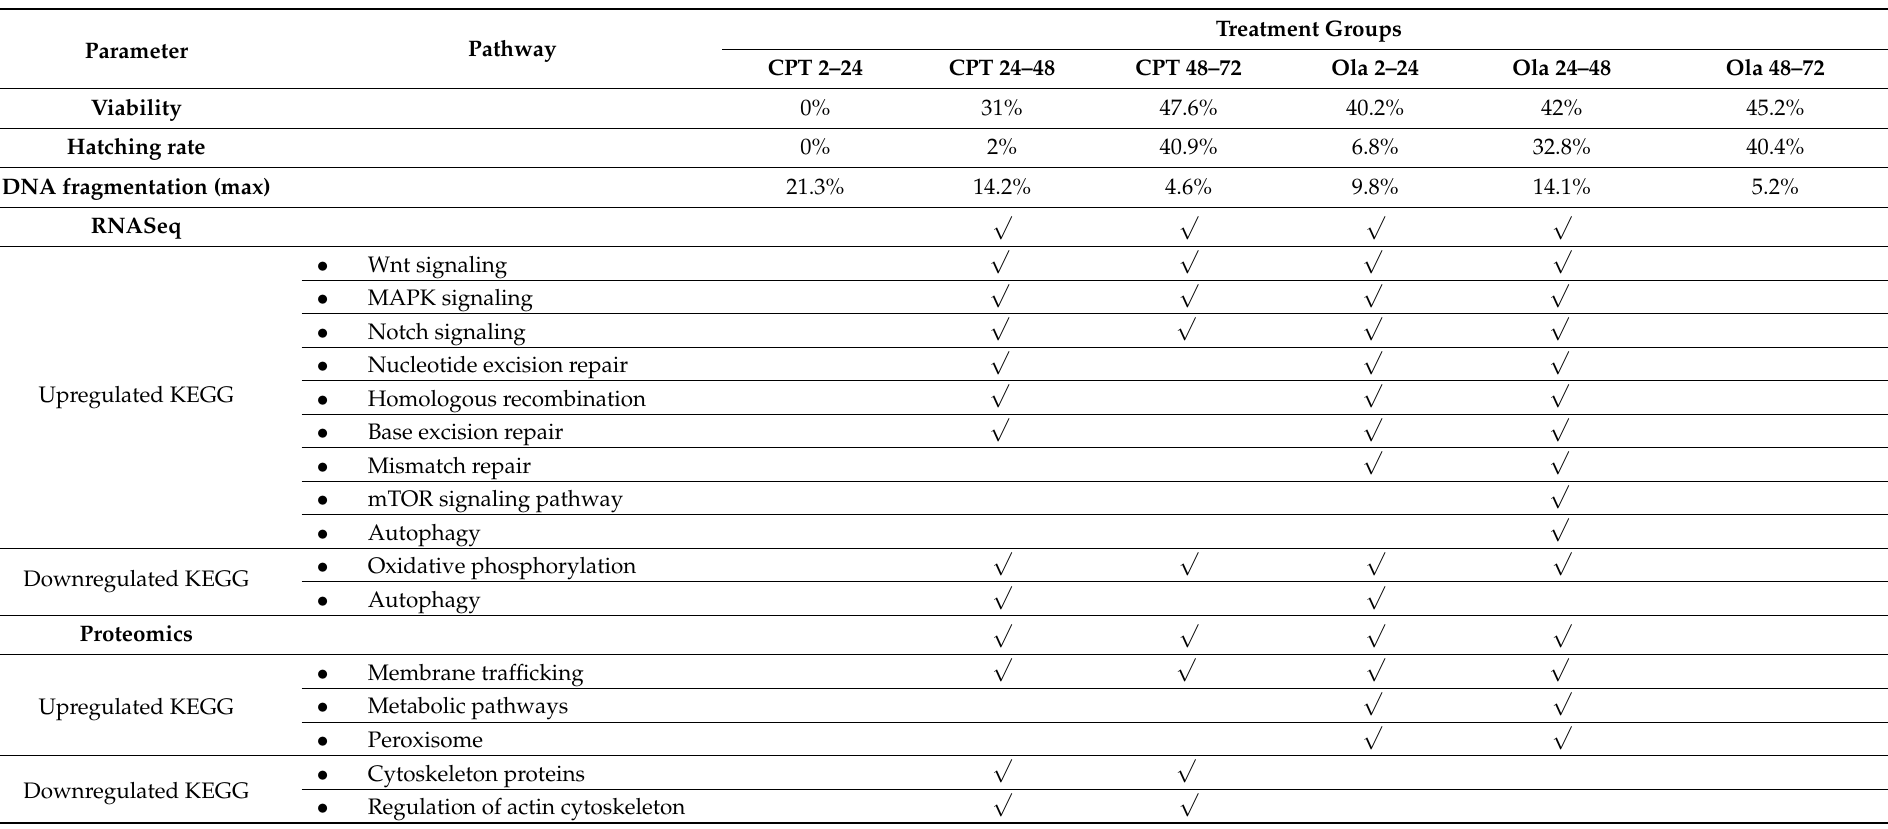
Table 1. Summary of the results obtained in the current study for sterlet ( A. ruthenus ) embryos exposed to 7 nM camptothecin (CPT) and 20 µ M olaparib (Ola) at different stages of embryo development: 2–24, 24–48, and 48–72 h post-fertilization. The maximum value of DNA fragmentation is shown for each condition. Viability and hatching rate are shown for 7 days